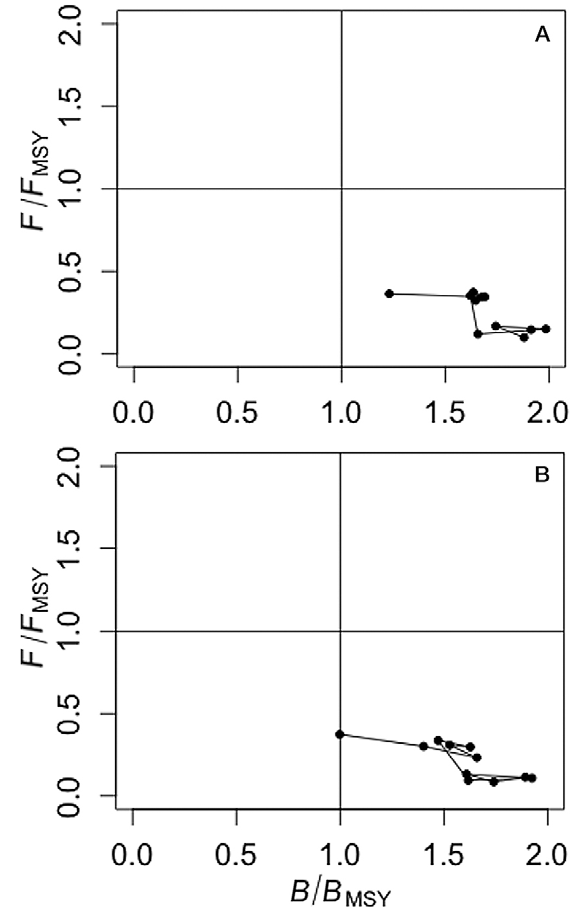
Fig. 4. – Development of the O. bartramii fishery from 2003 to 2013 based on the SP model (A) and the P